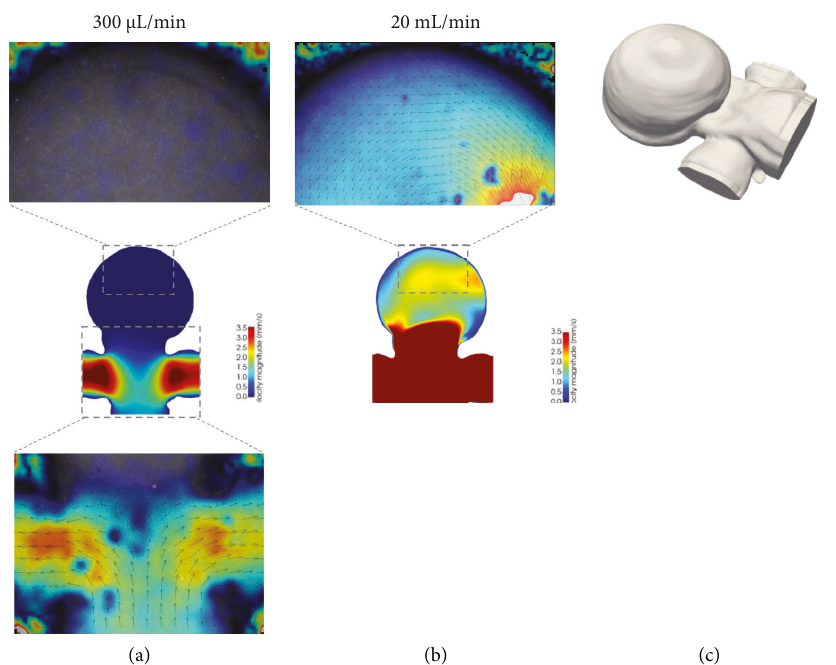
Figure 4: Particle image velocimetry (PIV) analysis and 3D computational flow model simulations. (a) (Above) PIV measurement at the back of the aneurysm dome showing no detectable flow at a 300- µ l min − 1 flow rate. (Middle) A 3D flow simulation of the same geometry and flow rate at z � − 0.66mm. (Below) PIV measurements within the parent and daughter vessels captured with a 2 × objective at the same flow rate. (b) (Above) PIV measurement gathered at the back of the aneurysm dome showing circular flow patterns and captured with